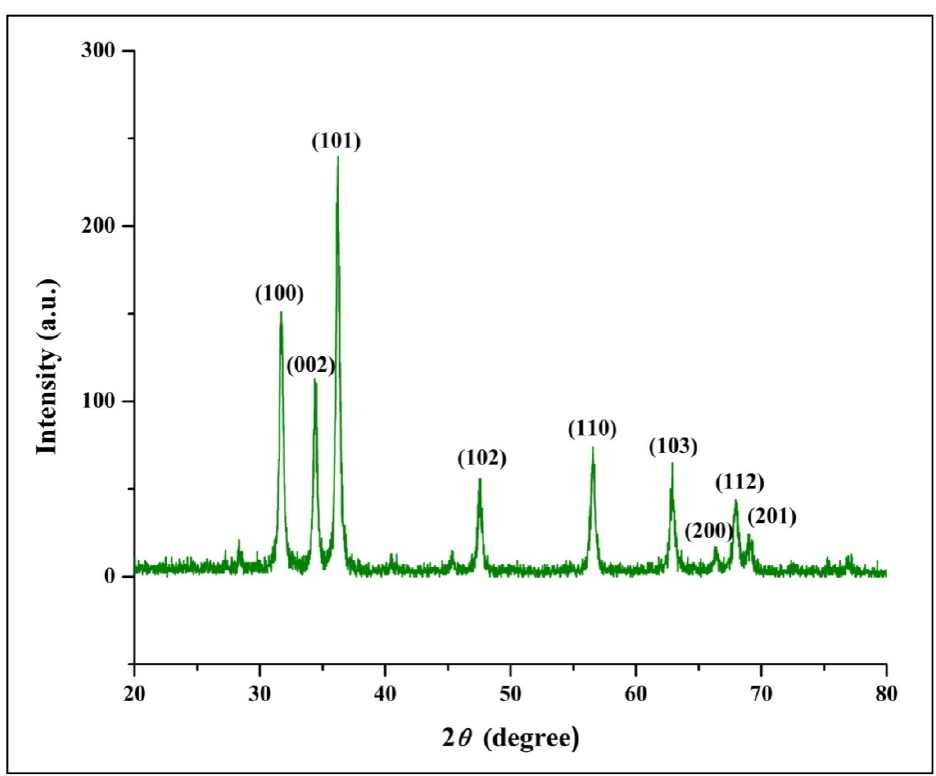
Figure 2. X-Ray Diffraction analysis of phyto-fabricated ZnO-NPs from I. obscura aqueous leaf extract.